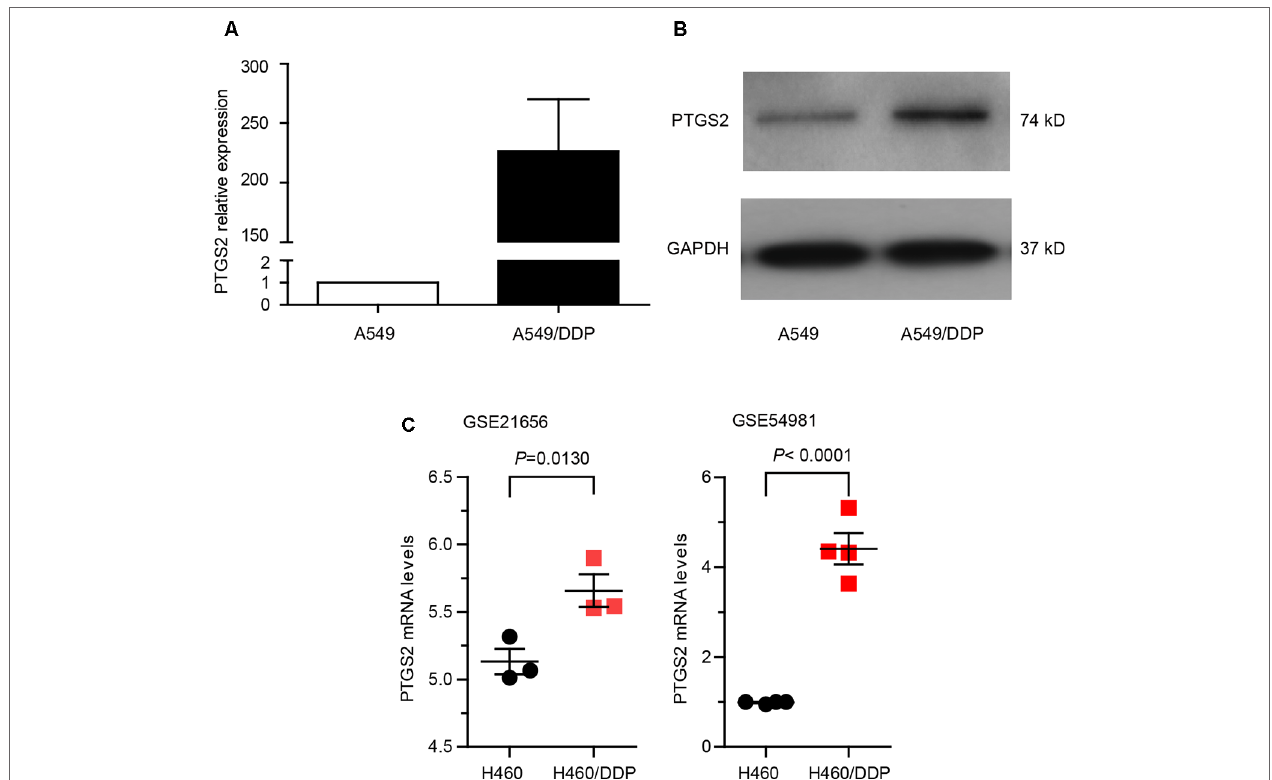
FIGURE 1 | Prostaglandin-endoperoxide synthase-2 (PTGS2) up-regulated in the cisplatin-resistant non-small cell lung cancer (NSCLC) cells promoted multidrug resistance. (A and B) Comparison of PTGS2 expression in A549 and A549/DDP cells were carried out by quantitative PCR (q-PCR) and Western blotting. A549 and A549/DDP cells (5 × 10 6 ) were lysed to obtain samples for Reverse Transcription - quantitative Polymerase Chain Reaction (RT-qPCR) and Western blot analysis. Fold change is calculated relative to A549 cells. (C) Analysis of two datasets (GSE21656 and GSE54981) in GEO (Gene Expression Omnibus). Data analysis indicated that PTGS2 was elevated in H460/DDP